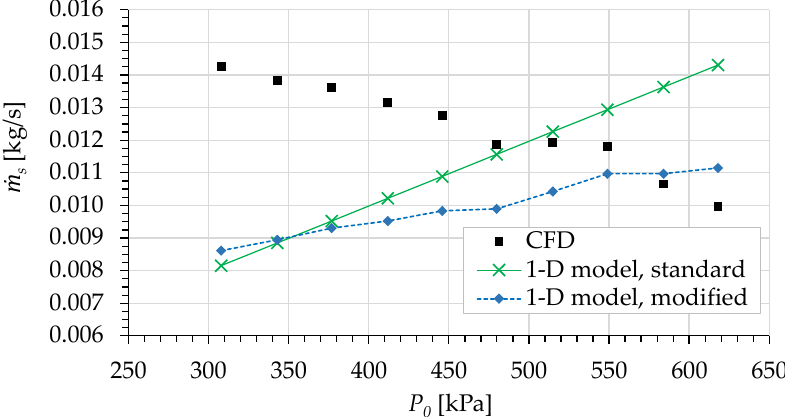
Figure 17. The secondary mass flow rates of ejector G2 obtained from various methods for different primary pressures.